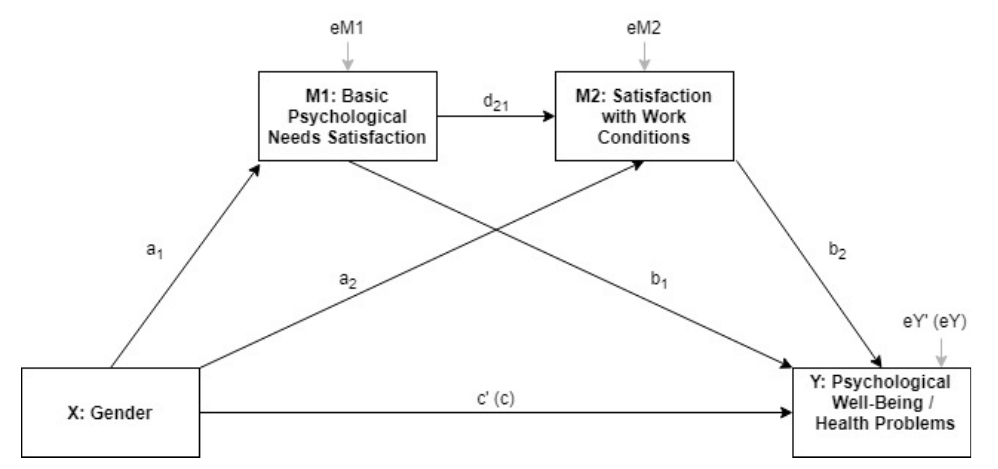
Figure 1. Multiple partial mediation model implemented to examine mediators in gender differences in psychological well-being and health problems.